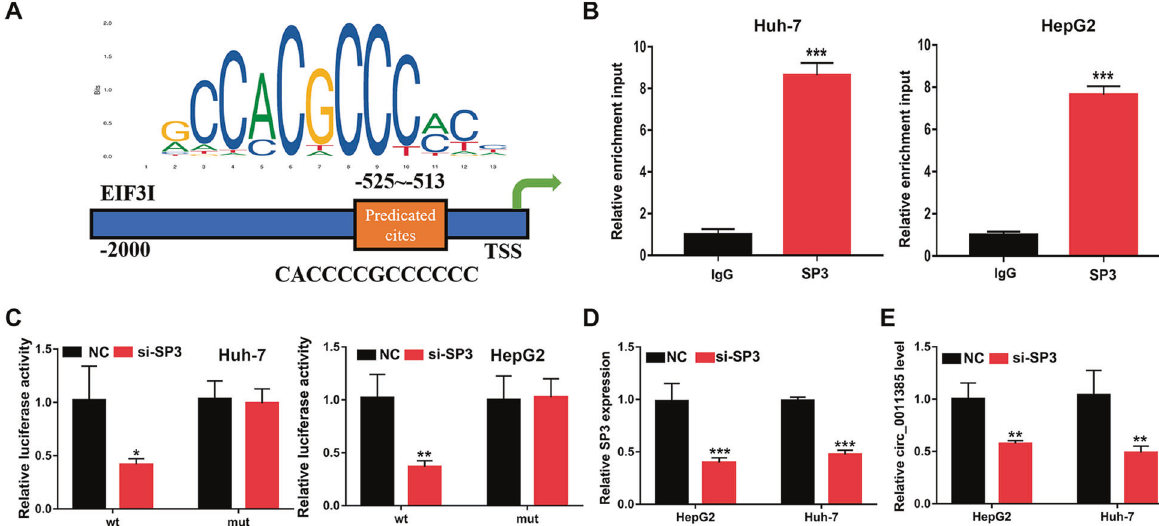
Fig. 6 SP3 activates circ_0011385 expression. A A potential binding site for SP3 in the circ_0011385 promoter. B ChIP assay indicating SP3 occupancy of the circ_0011385 promoter. C Relative luciferase activity analyzed in Huh-7 and HepG2 cells. D , E Relative STC2 and circ_0011385 expression in Huh-7 and HepG2 cells. Data ( n = 5) are the means ± SD. *P < 0.05, ** P < 0.01, *** P <